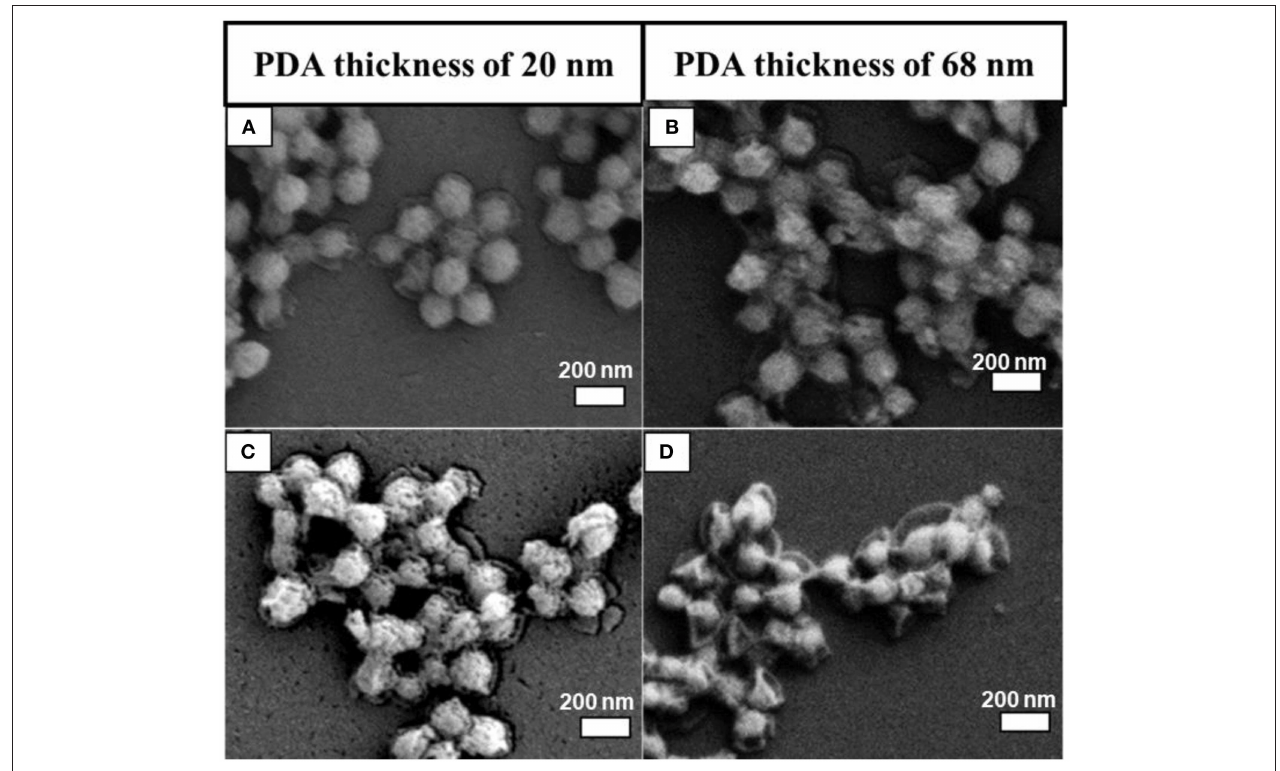
FIGURE 3 | SEM images of MSN@PDA coated at room temperature with different PDA coating thickness after 24h (A,B) and 48h water dispersion (C,D) .